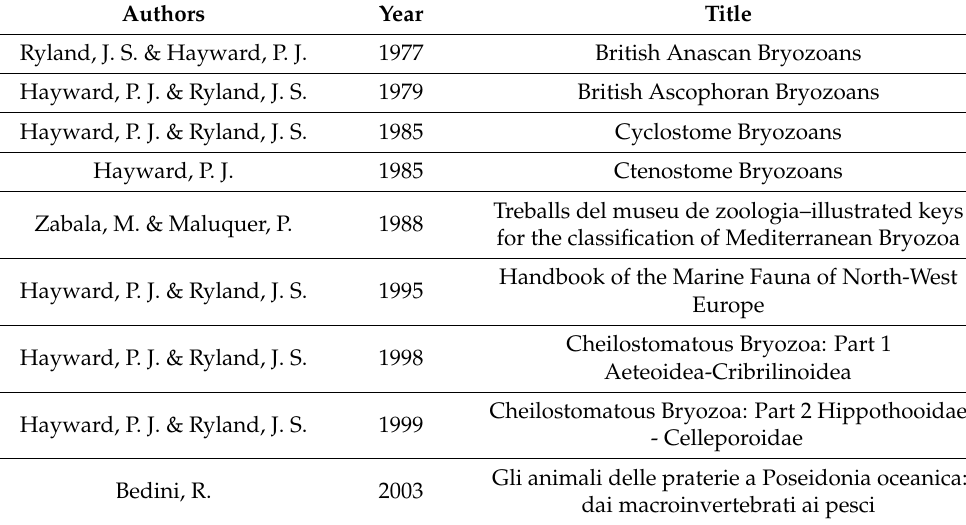
Table A2. Literature used for species